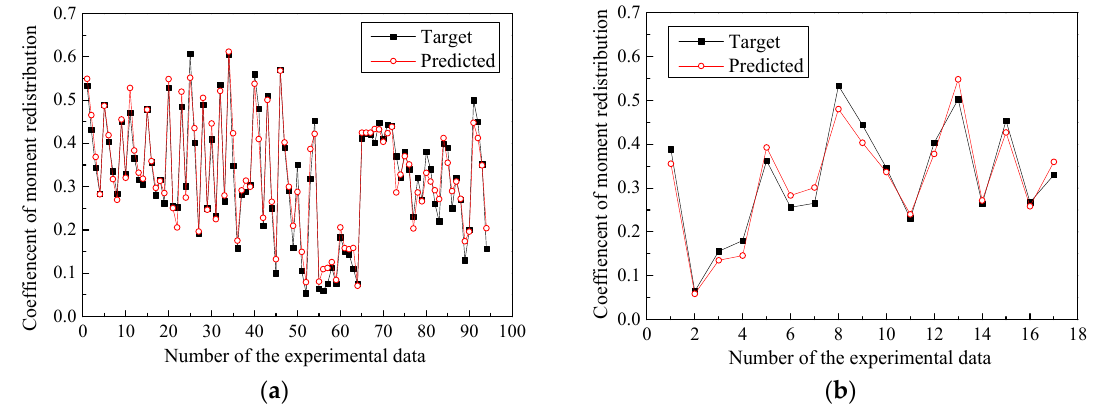
Figure 12. Comparison of predicted values with ANN model with experimental results: ( a ) training sets; and ( b ) testing sets.